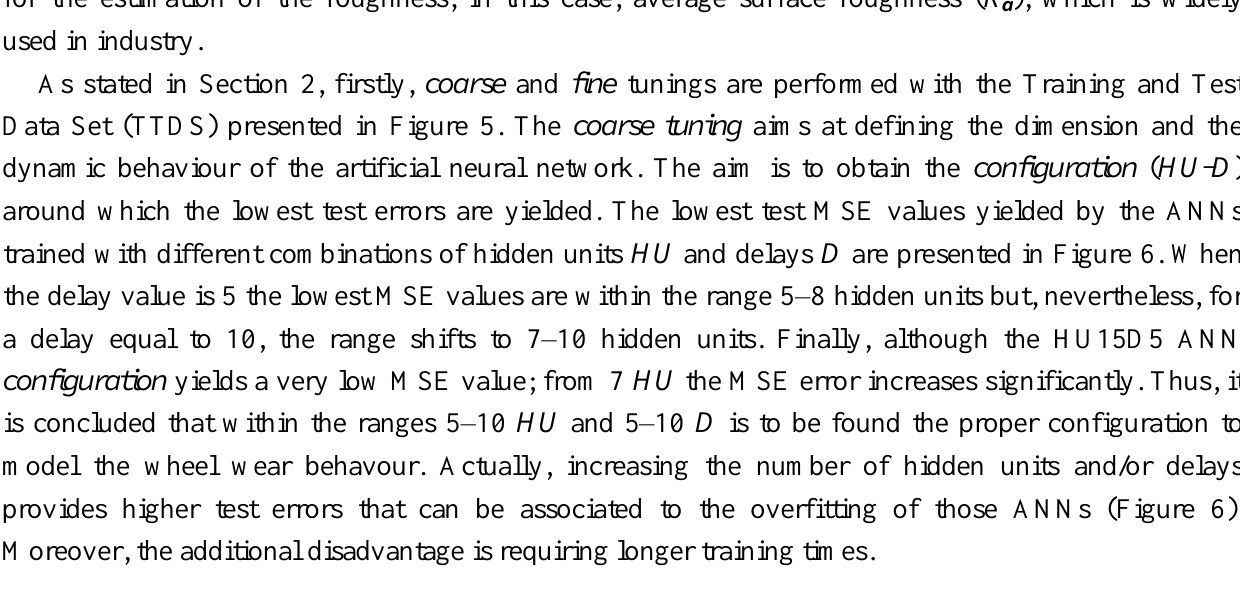
Figure 6. Summary of the results of coarse